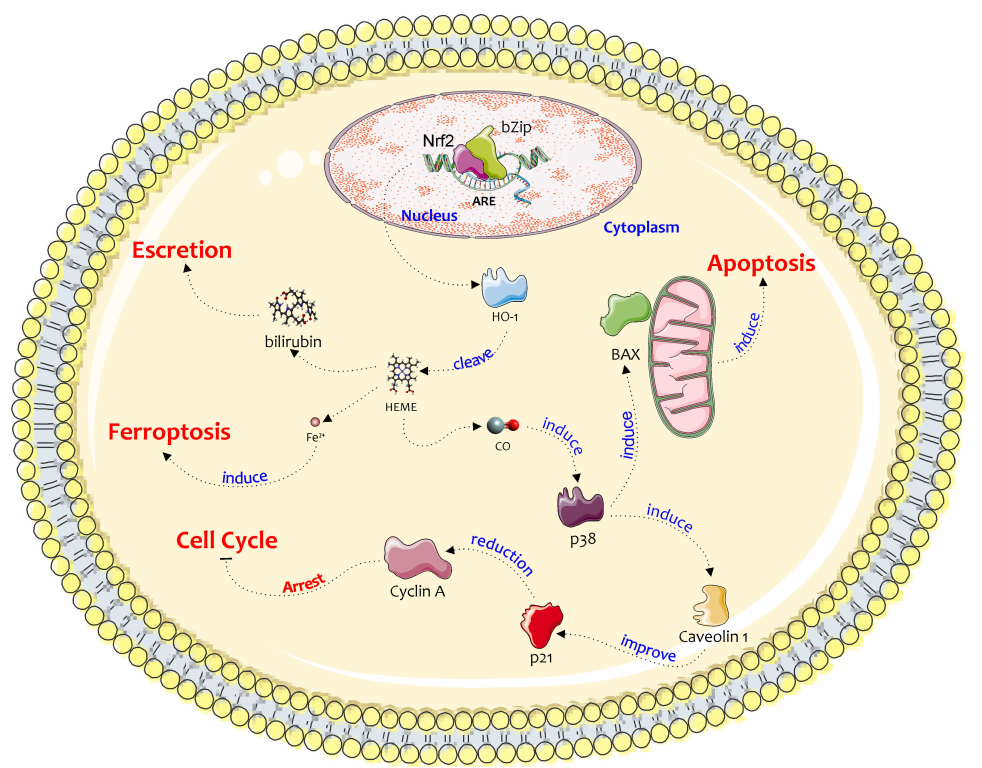
Figure 3. A possible anticancer pathway of HO-1 in neuroblastoma cells. The figure shows di ff erent pathways induced by NRF2 action on HO-1. All pathways converge through the stress of other factors, such as the splitting of the heme group and the release of Fe + ions, the arrest of the cell cycle with induction of p21 or through BAX and classic apoptosis. This figure was drawn using the software CorelDraw and the vector image bank of Servier Medical Art (http: // smart.servier.com /